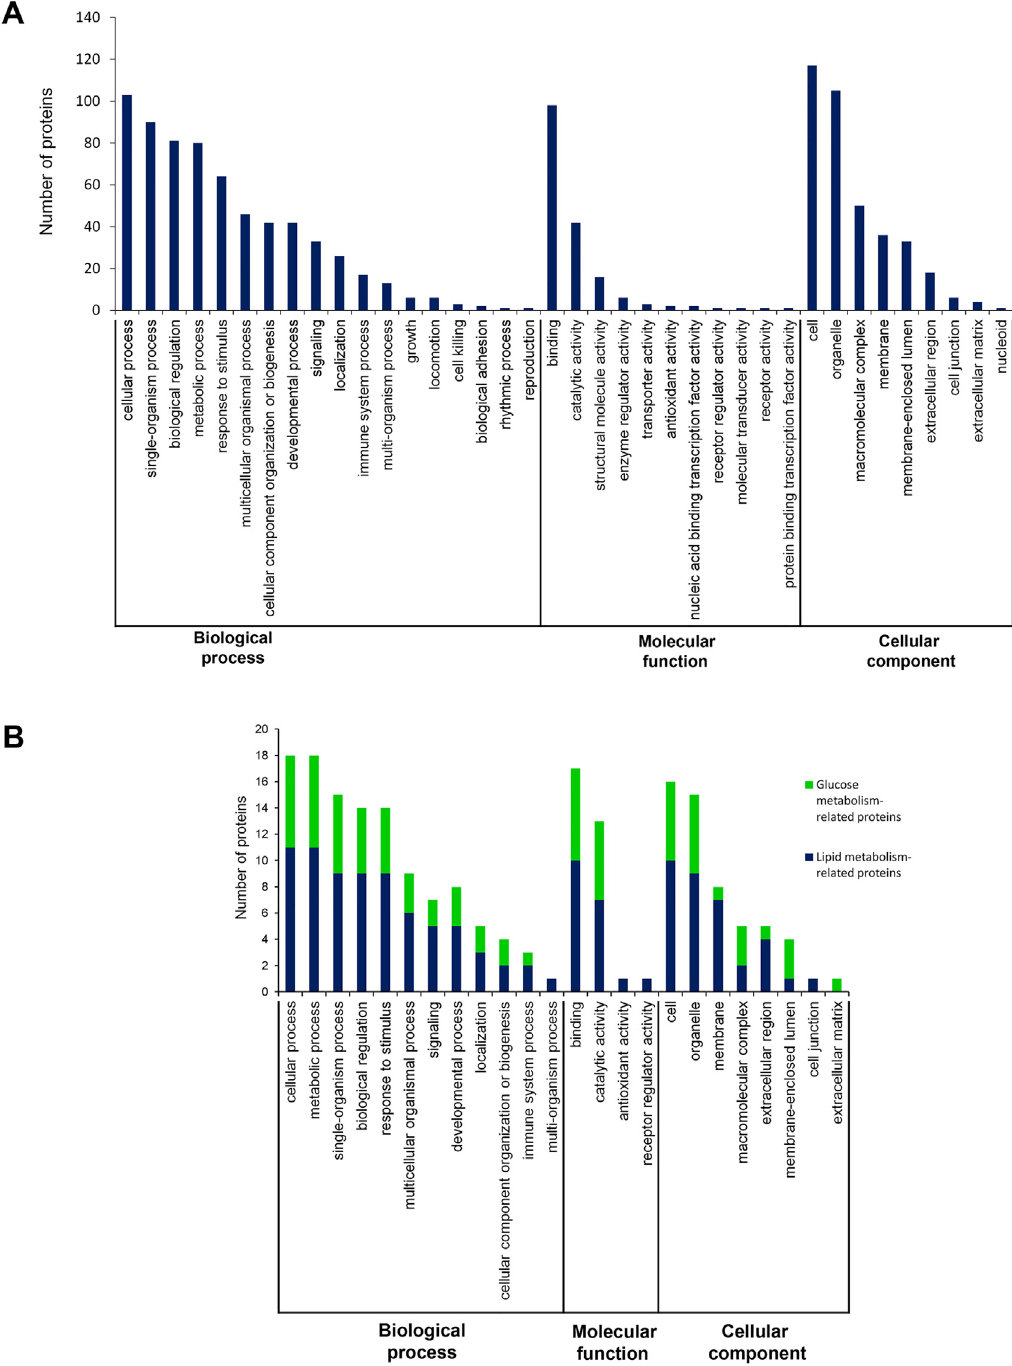
Fig 3. Quantitative identification and bioinformatics analysis of tumor tissue proteins assayed by iTRAQ. (A) All 132 differentially accumulated proteins were classified into three groups: biological process, molecular function, and cellular component through GO analysis. (B) The numbers of lipid/ glucose metabolism-related proteins were shown through GO